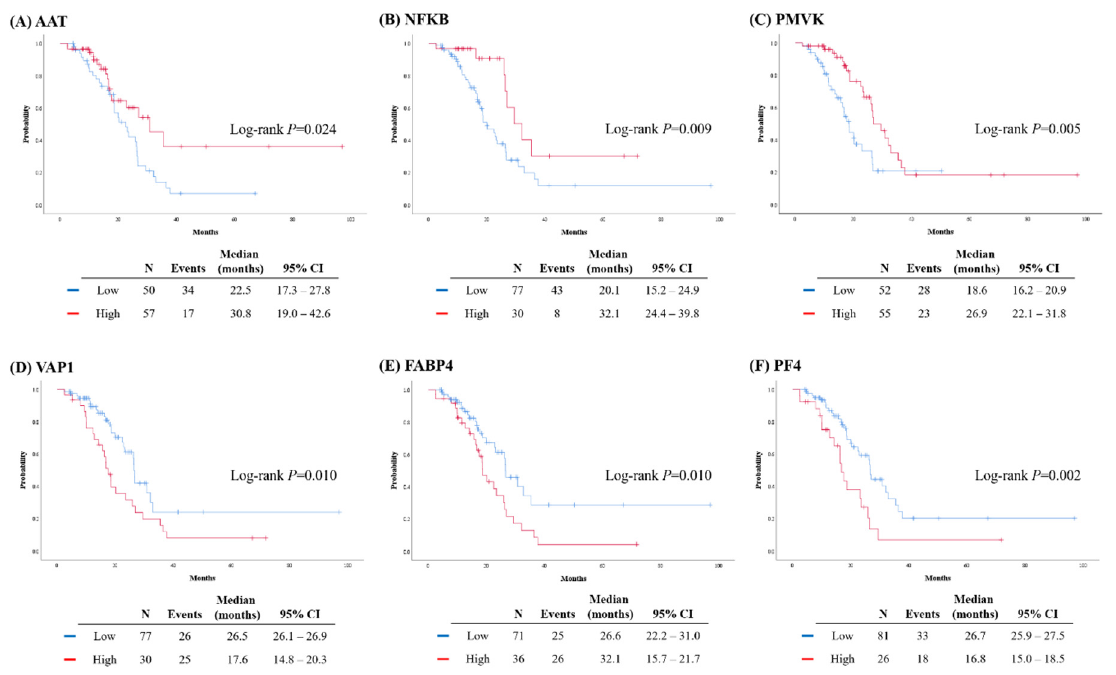
Figure 4. Comparison of progression-free survival (PFS) based on the expression levels of proteins: ( A ) α 1-antitrypsin (AAT); ( B ) nuclear factor- κ B (NFKB); ( C ) PMVK; ( D ) vascular adhesion protein 1(VAP1); ( E ) fatty acid-binding protein 4 (FABP4); ( F ) PF4.